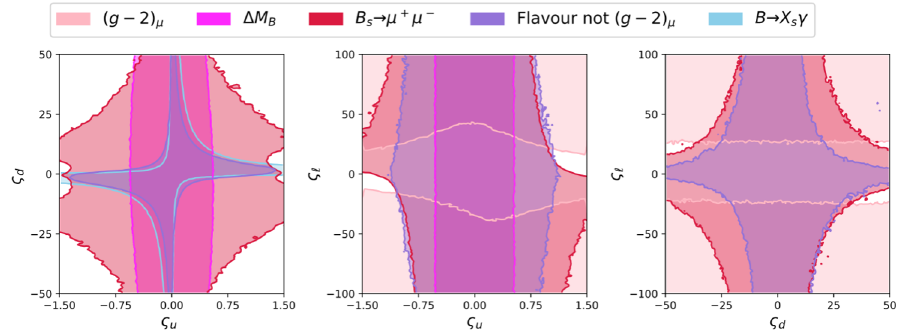
Figure 6. Constraints at the 95.5% probability on the alignment parameters from ( g − 2) µ (light pink), B s → µ + µ − (red), meson mixing (dark pink), B → X s γ (blue) and all flavour observables except ( g − 2) µ (purple). For clarity observables that do not give relevant constraints in a given plane are omitted from the